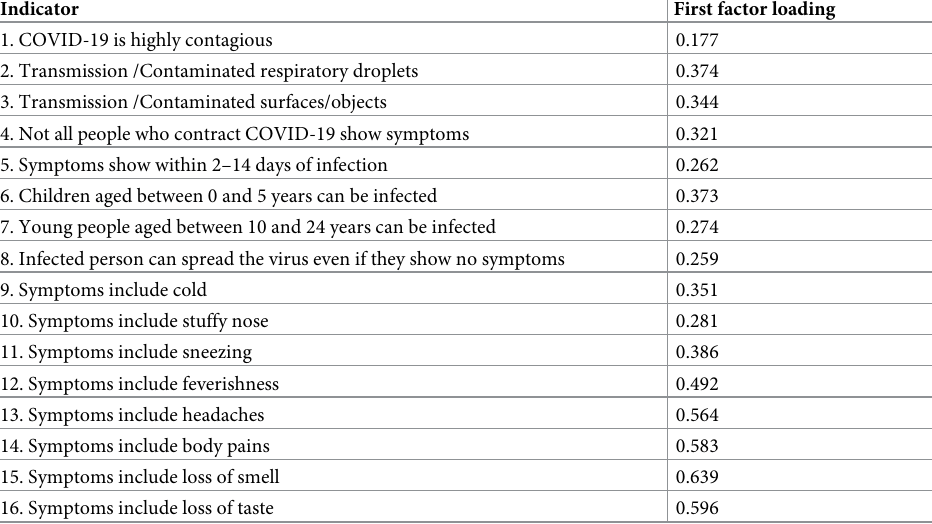
Table 2. Indicators used to measure knowledge of